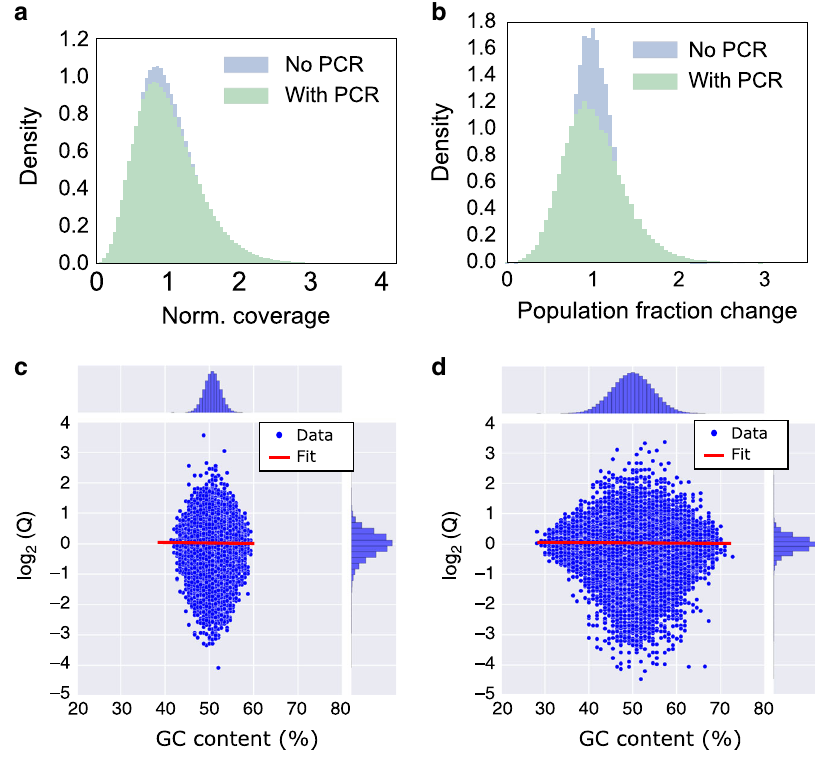
Fig. 4 PCR-induced Population Fraction Changes and Impact of GC content. a Histogram of sequencing coverages for optimized ready-to-sequence pool. The ready-to-sequence pool was sequenced directly, without PCR (blue). The same pool was ampli fi ed using PCR for 31 cycles (green) and sequenced separately. Both were randomly sampled to coverage of 20× for direct comparison, and they look quite similar (c.v. = 0.41 and c.v. = 0.45, respectively). b The blue histogram shows the population fraction change Q distribution of the ready-to-sequence pool, before PCR, after being subsampled to 20x coverage, with respect to its overall available coverage (60×). The green histogram shows the population fraction change Q distribution of the ready-to- sequence pool, after PCR and after being subsampled to 20x coverage, with respect to the pre-PCR pool distribution at 60x coverage. The blue distribution shows the effect of subsampling, while the further widening of the green curve with respect to the blue curve is attributed to stochastic bias in the PCR process. The sample size (number of unique sequences) in a , b is 1,536,168. c , d The GC content is plotted against the log 2 of the population fraction change Q for the ready-to-sequence, non-homopolymer pool ( c ) and a homopolymer pool ( d ). The experimental data are shown as blue dots, and the linear fi t is shown as a red line. The histograms of GC content and log 2 ( Q ) are shown at the top and right, respectively. The sample size (number of unique sequences) in c , d is 1,536,168 and 1,358,998, respectively. Source data are available in the Source Data fi